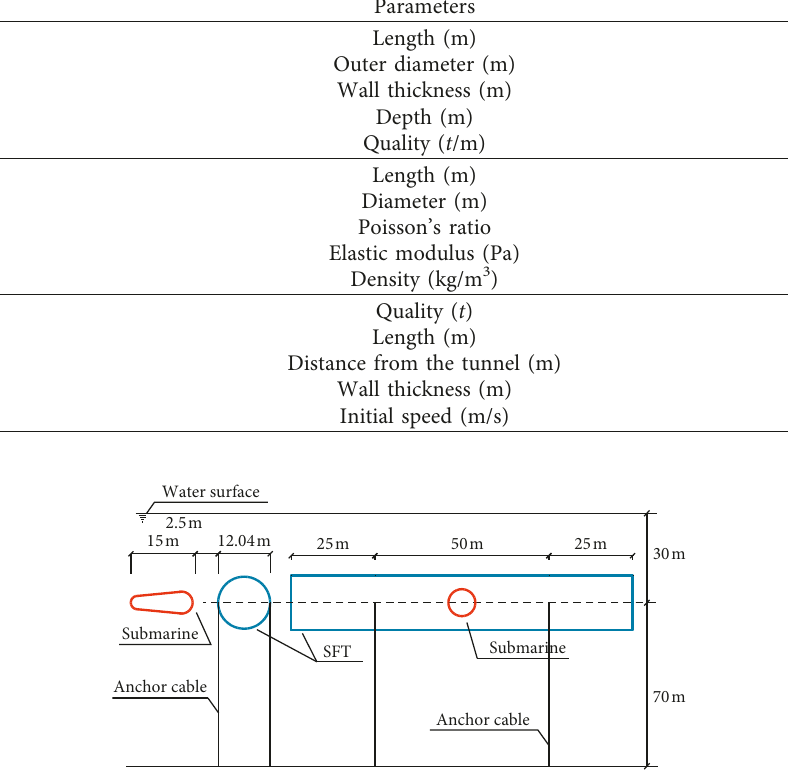
Figure 1: Geometric